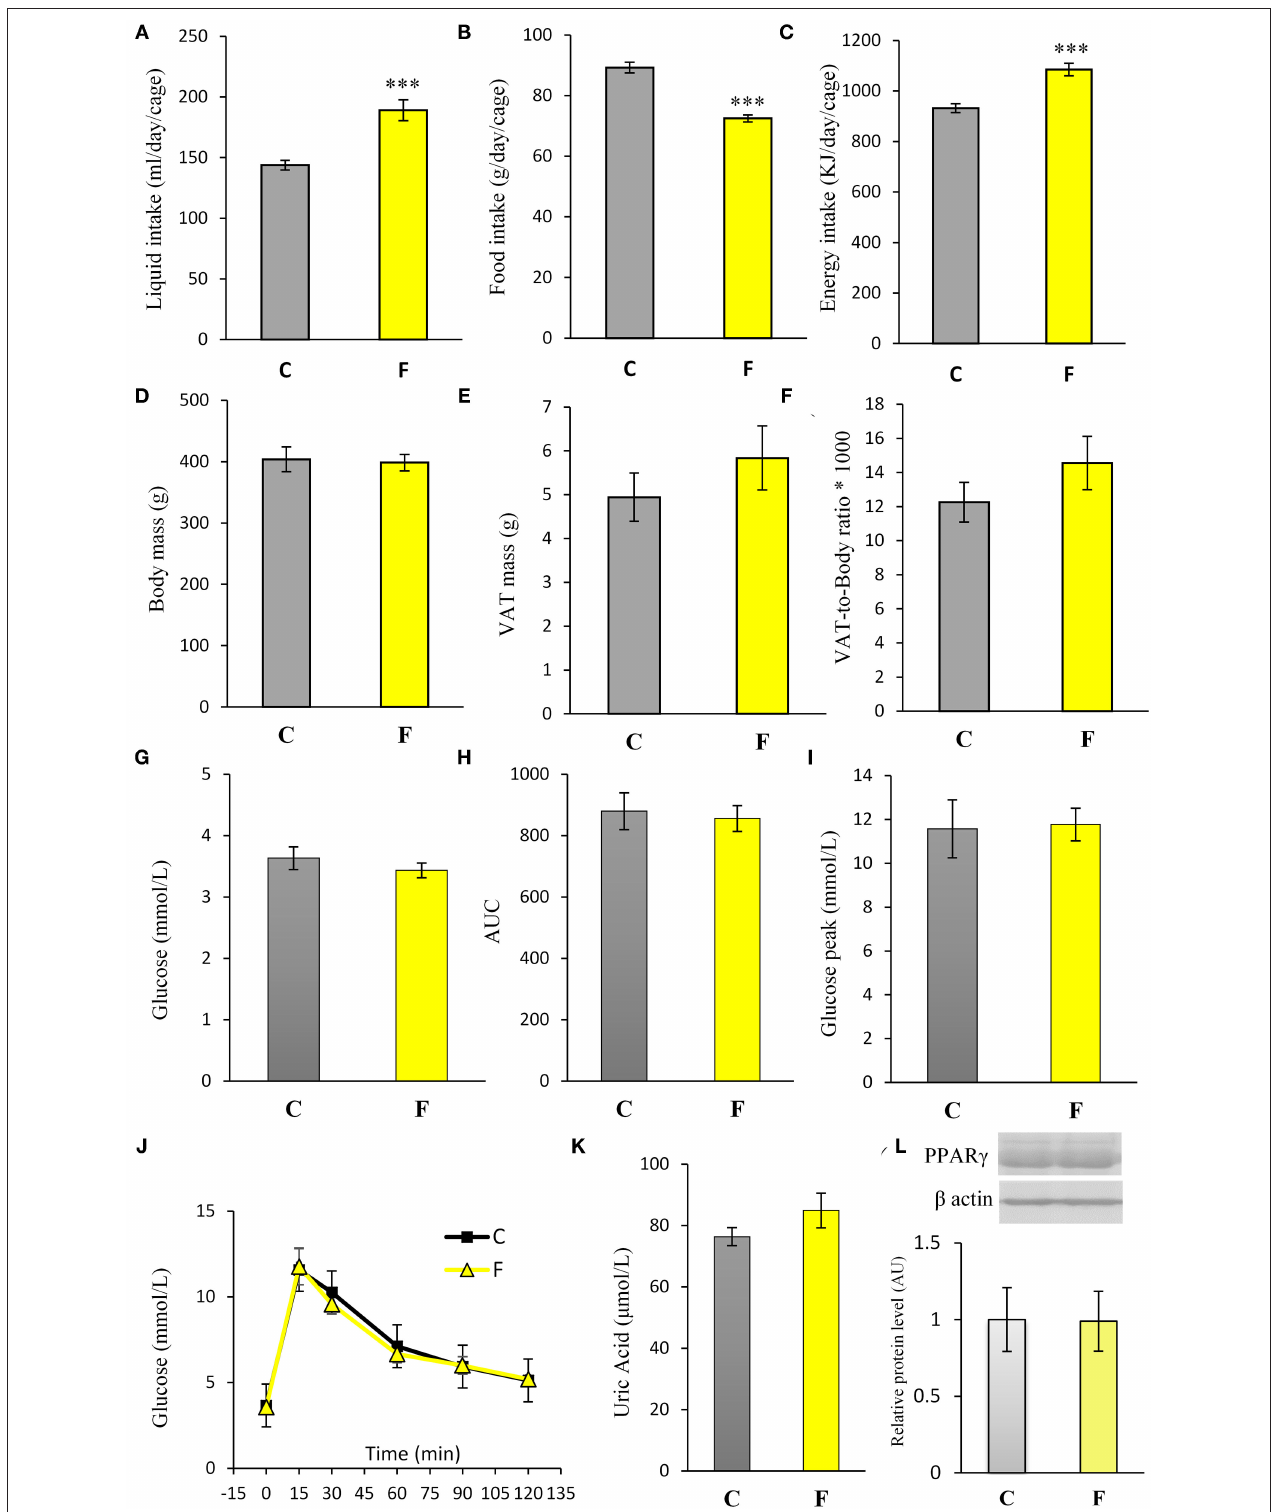
FIGURE 4 | Physiological and biochemical parameters of male rats fed with 10% fructose diet for 9 weeks. (A) Liquid, (B) food, and (C) energy intake were measured per day and per cage. Values are expressed as mean ± SEM ( n = 3 cages). (D) Body mass, (E) VAT mass, and (F) VAT-to-body ratio; (G) blood glucose level, (H) AUC values, (I) glucose peak, (J) IPGTT, (K) plasma uric acid level and (L) PPAR γ protein level were determined in the control (C) and fructose-fed (F) male rats. The values represent the mean ± SEM ( n = 8 animals per group). Statistical significance of between-group differences (Student’s t -test): *** P < 0.001, F vs. C.